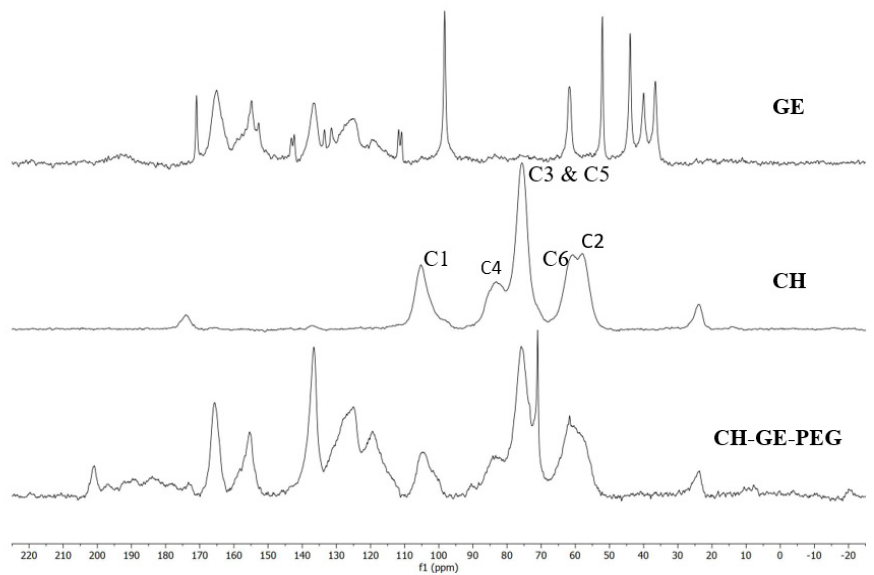
Figure 3. 1 H- 13 C-NMR spectra of CH, GE and the CH–GE–PEG 3D printed film.